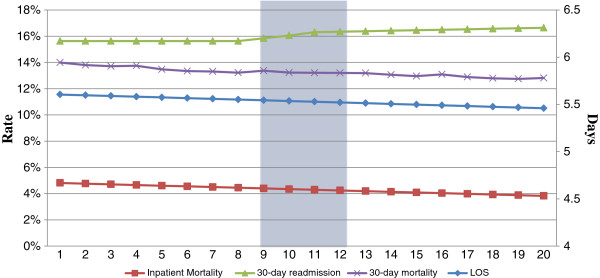
Outcomes in EMR adopted group two years before and two years after EMR adoption year.